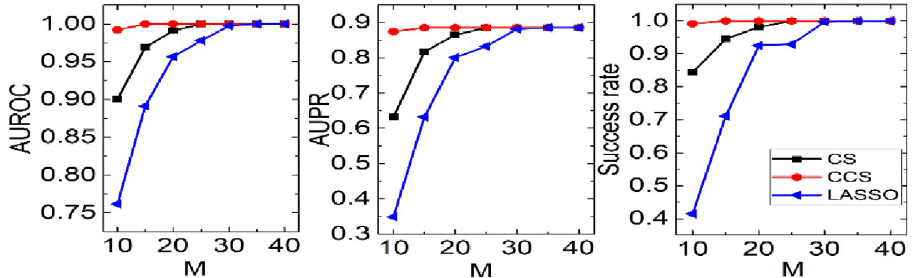
Fig 8. The performance of CCS, CS and LASSO is shown with three evaluation indexes on the coupled-oscillator dynamics. Network size N = 100, average degree < k > = 6.